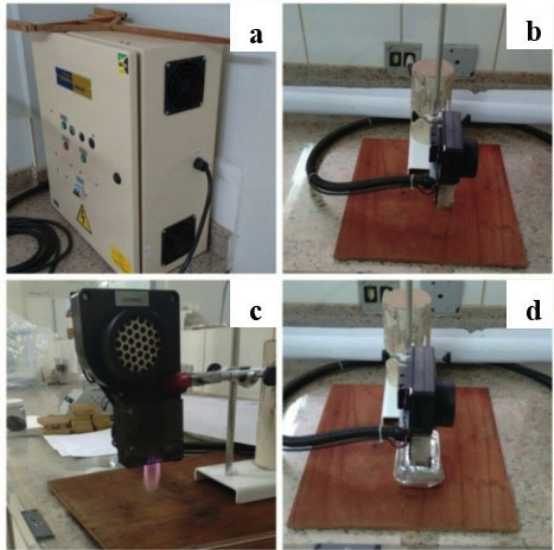
Figure 1 - Corona equipment ( a ) control box; ( b ) head; ( c ) discharging head; ( d ) surface treatment